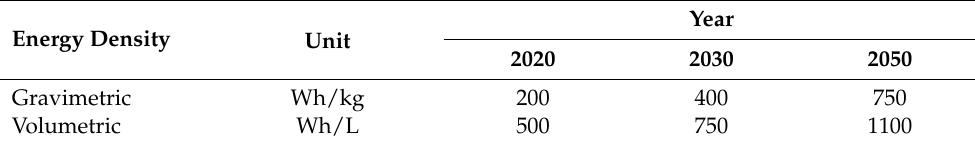
Table 6. The expected increase in battery energy